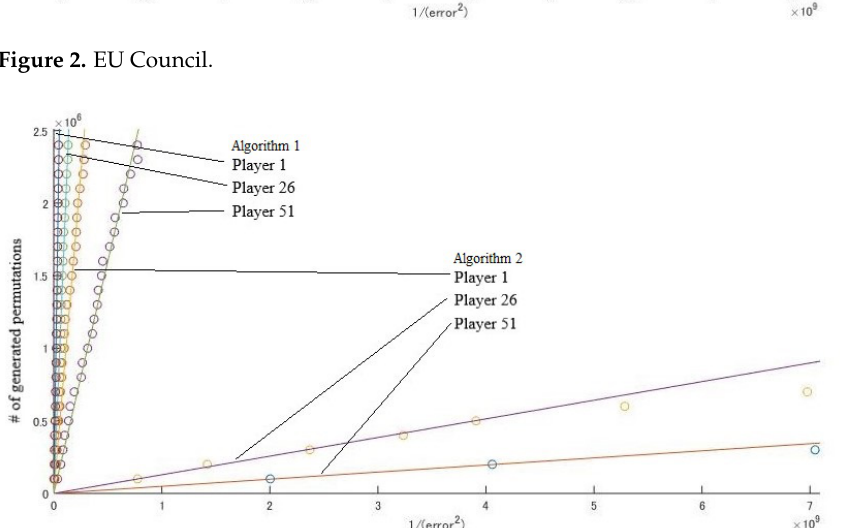
Figure 3. United